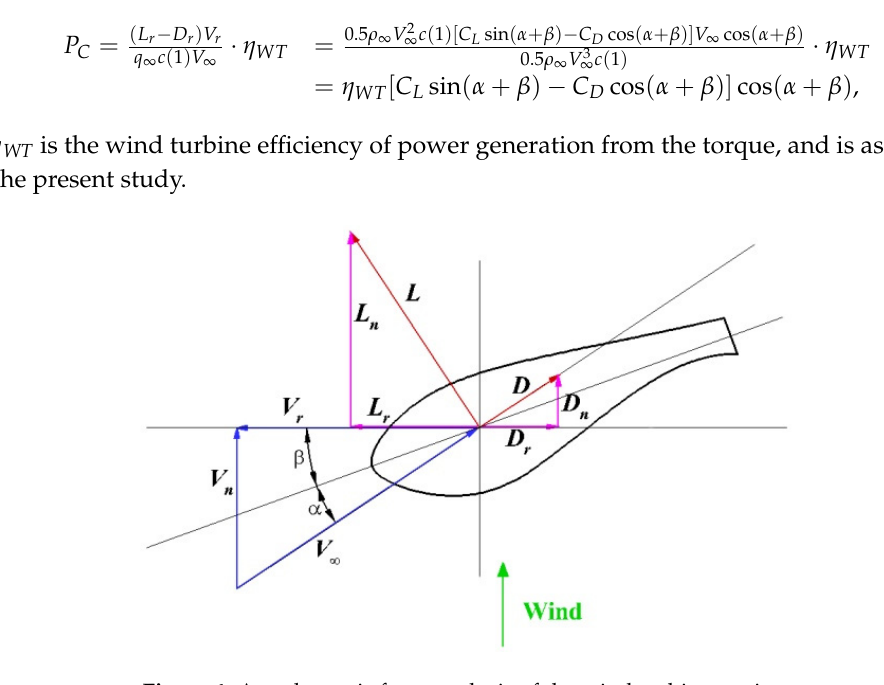
Figure 4. Aerodynamic force analysis of the wind turbine section.